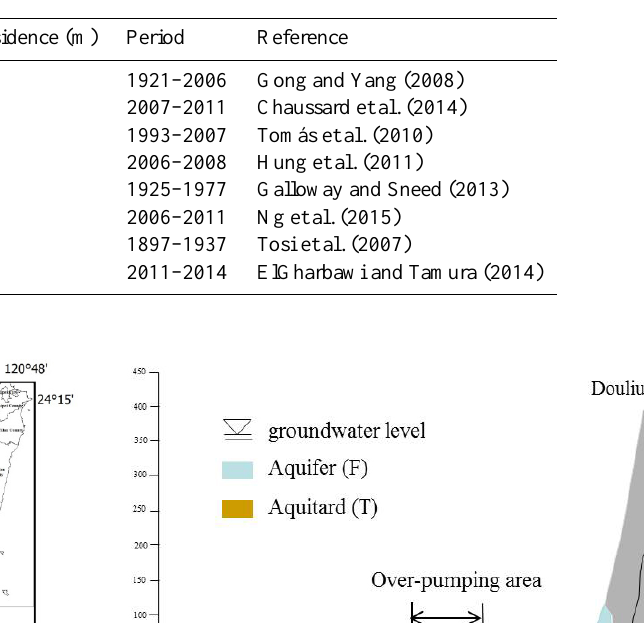
Table 1. A list of world countries experiencing subsidence problems.